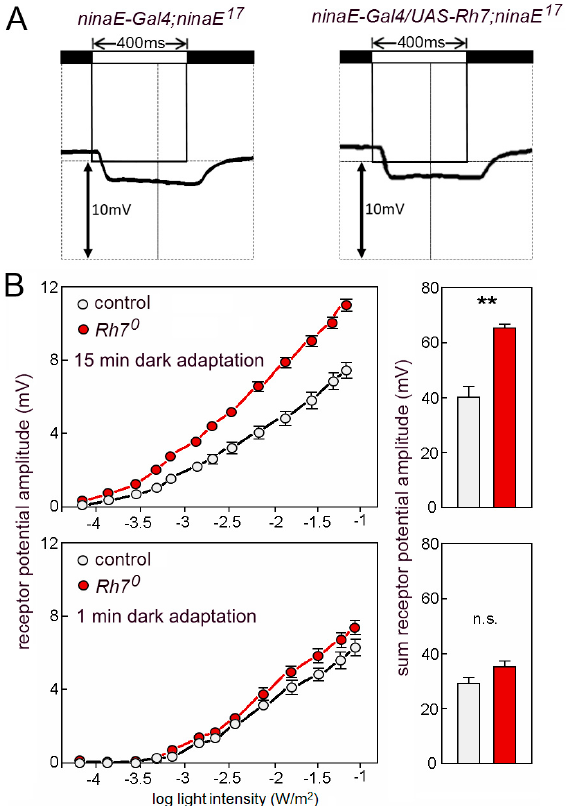
Figure 7. ( A ) ERGs using 400 ms light pulses of UV light (365nm). ninaE 17 mutant controls and ninaE 17 mutants that express Rh7 in the outer receptor cells R1–R6 lack the lights-on and the lights-off transients and show the same low receptor potential that stems from the inner receptor cells. ( B ) Rh7 reduces the ERG amplitudes to white light in dark-adapted flies. Irradiance response curves of the receptor potential amplitudes in the white-eyed Rh7 0 mutants and the relevant white-eyed controls in dark- (top) and light-adapted (bottom) flies. The statistical comparison of the summed receptor potentials is shown in the right panels.